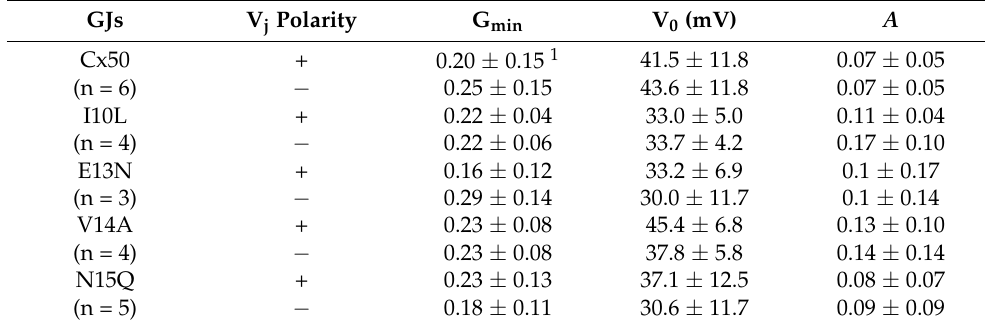
Table 2. Boltzmann fitting parameters for the GJs of Cx50 and its